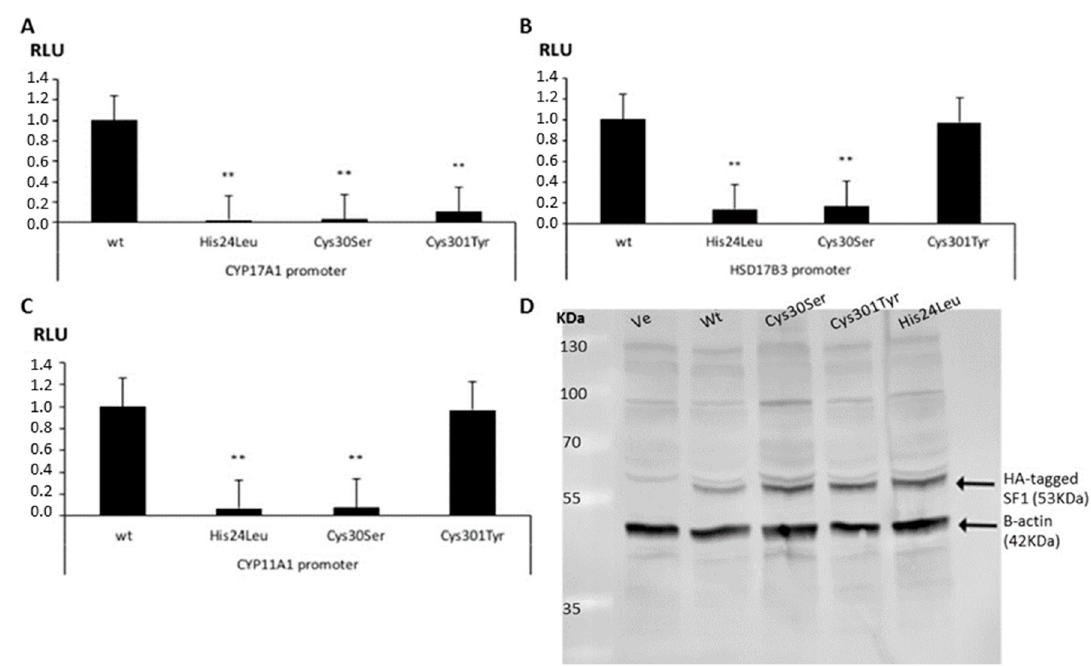
Figure 2. Functional studies of the three novel NR5A1 variants. The ability of wild-type (WT) and mutant NR5A1 to activate promoter luciferase reporter constructs was tested in HEK293 cells ( A – C ). Cells were transiently transfected with NR5A1 expression vectors and promoter reporter constructs: 227CYP17A1_ Δ luc ( A ), -301HSD17B3_pGL3 ( B ) and -152CYP11A1_pGL3 ( C ) [7]. Results are shown as the mean ± standard error of the mean (SEM) of five independent experiments, all performed in duplicate. ( D ) Western blot showing expression of WT and mutant NR5A1/SF1 proteins. The HA antibody recognized hemagglutinin-tagged NR5A1/SF1 (band at 53 kDa). β -actin was used as a control (band at 42 kDa). ** p -value ≤ 0.01. HA, hemagglutinin; RLU, relative light units; Ve, empty vector; WT, wild type.